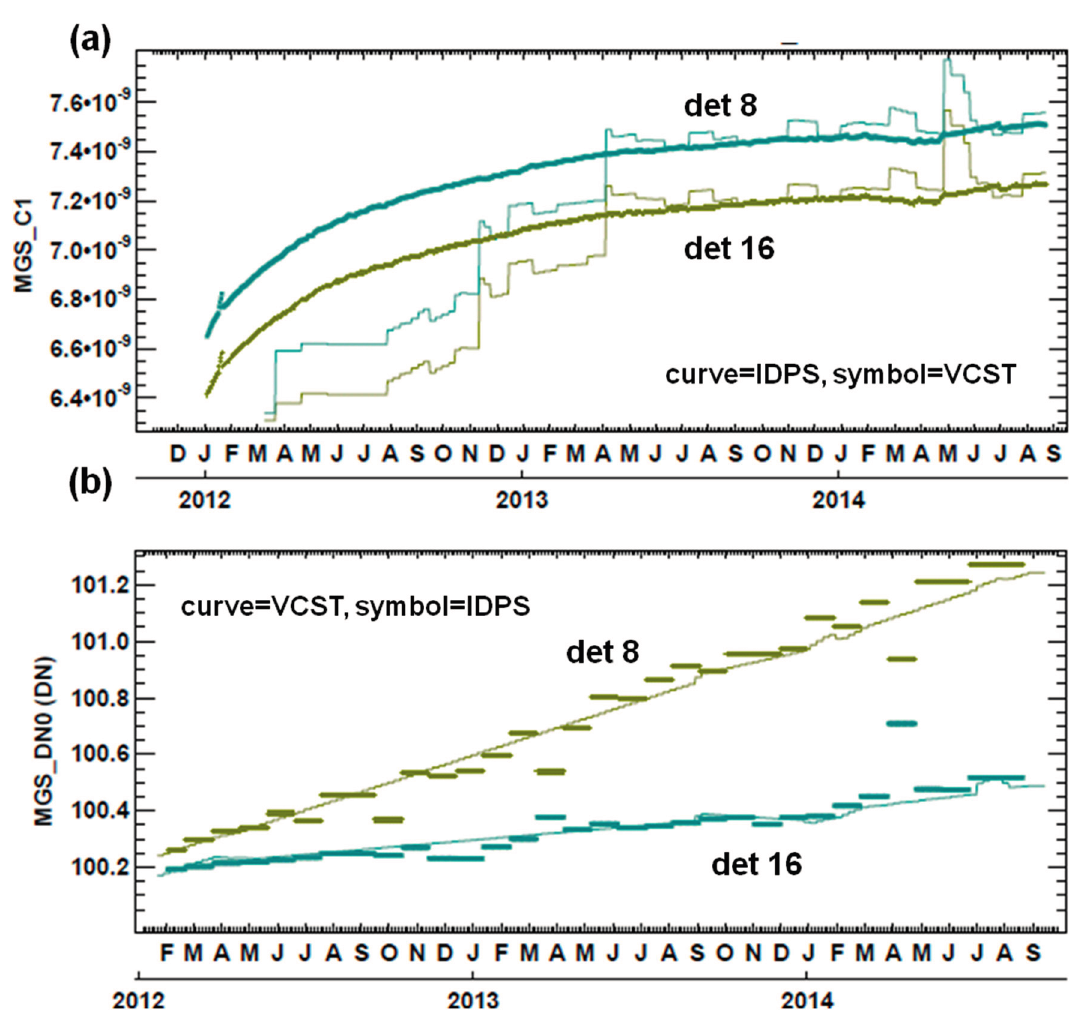
Figure 6. Comparison of daily averaged MGS gain and offset values between NASA and IDPS. ( a ) MGS gain coefficients (MGS_C1), in units of W·cm − 2 ·sr − 1 ; ( b ) MGS offset (MGS_DN0) in DNs. The plots show aggregation Mode 1, Detectors 8 and 16 as an